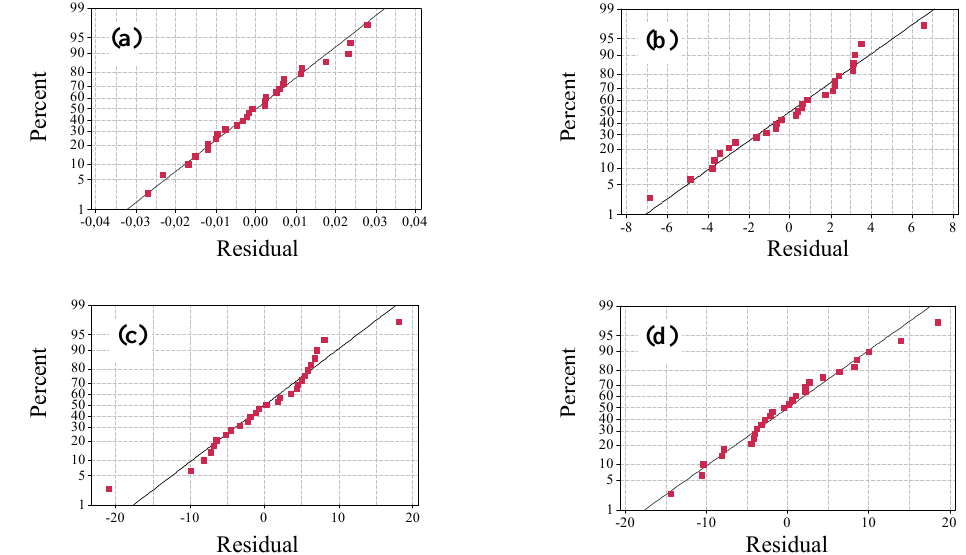
Fig.6. Normal probability plot of residuals for (a) Ra and for (b) Fa , (c) Fr and (d) Ft respectively